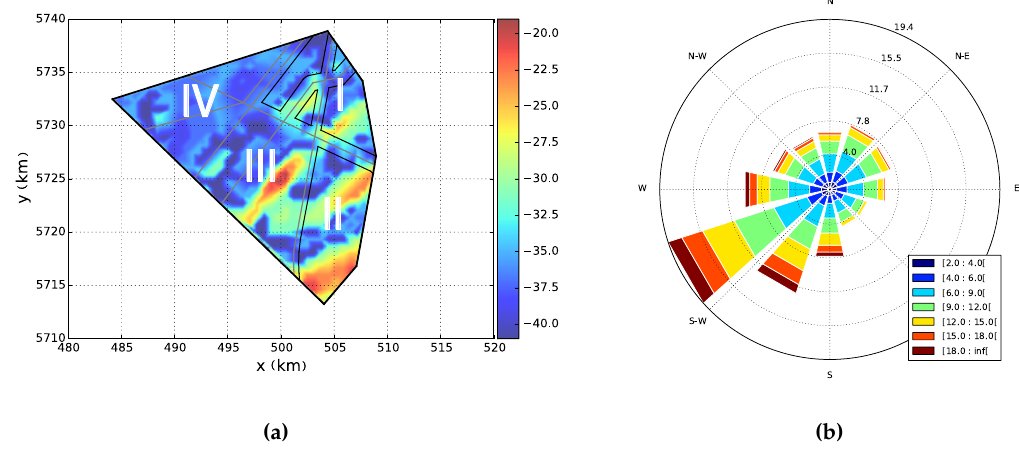
Figure 12. Description of the Borssele wind farm area, existing pipeline and telecom cables and water depth [84]. The color bar of the left figure represents the water depth in meters and the legend of the right figure presents the wind bins in m/s. ( a ) Wind farm water depth [84]; ( b ) Annual wind rose at height of 90 m